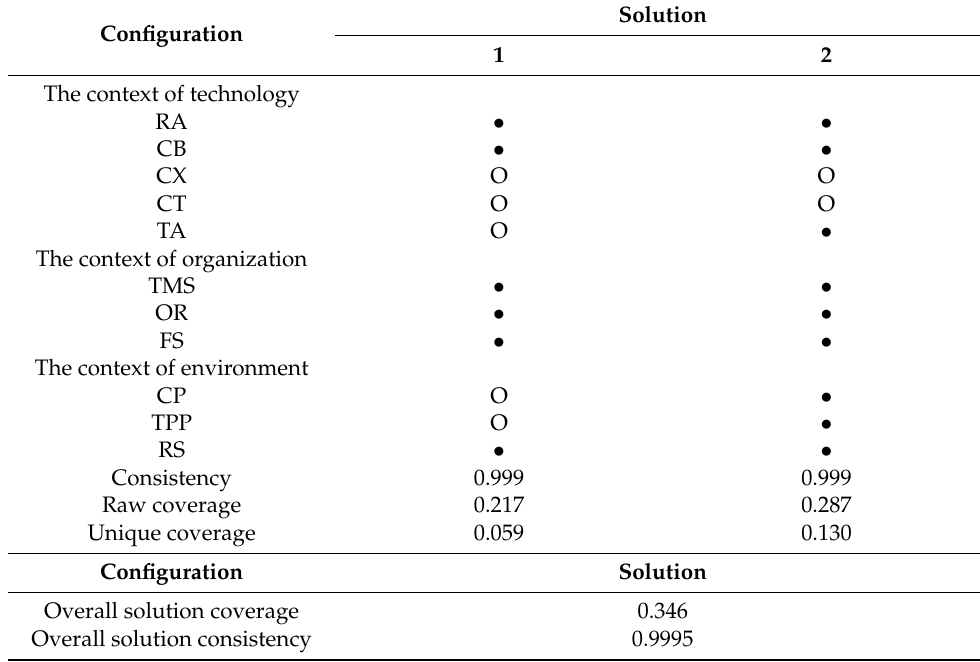
Table 5. Configurations for high blockchain adoption